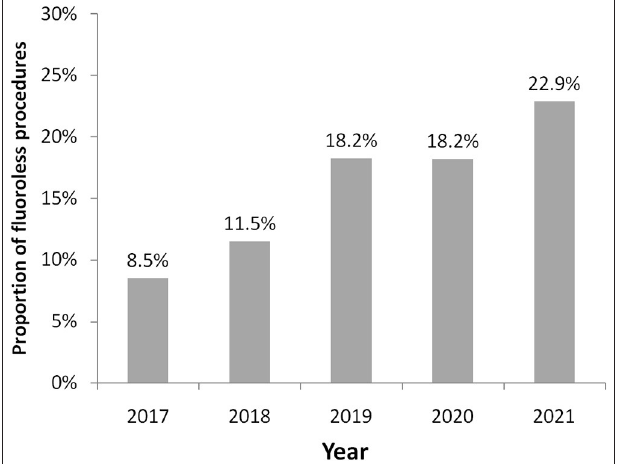
FIGURE 2 | Proportions of fluoroless procedures by calendar year. Trend of fluoroless